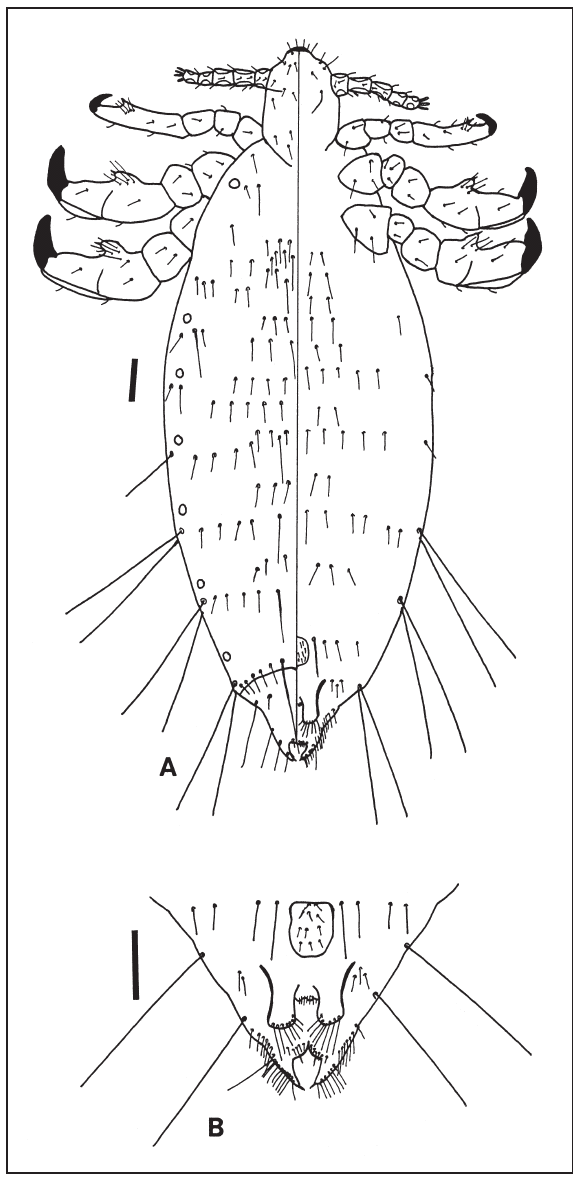
FIG. 2 Linognathus weisseri , n. sp., female. A. Dorso-ventral view. B. Genitalia. Both scale bars = 0.1